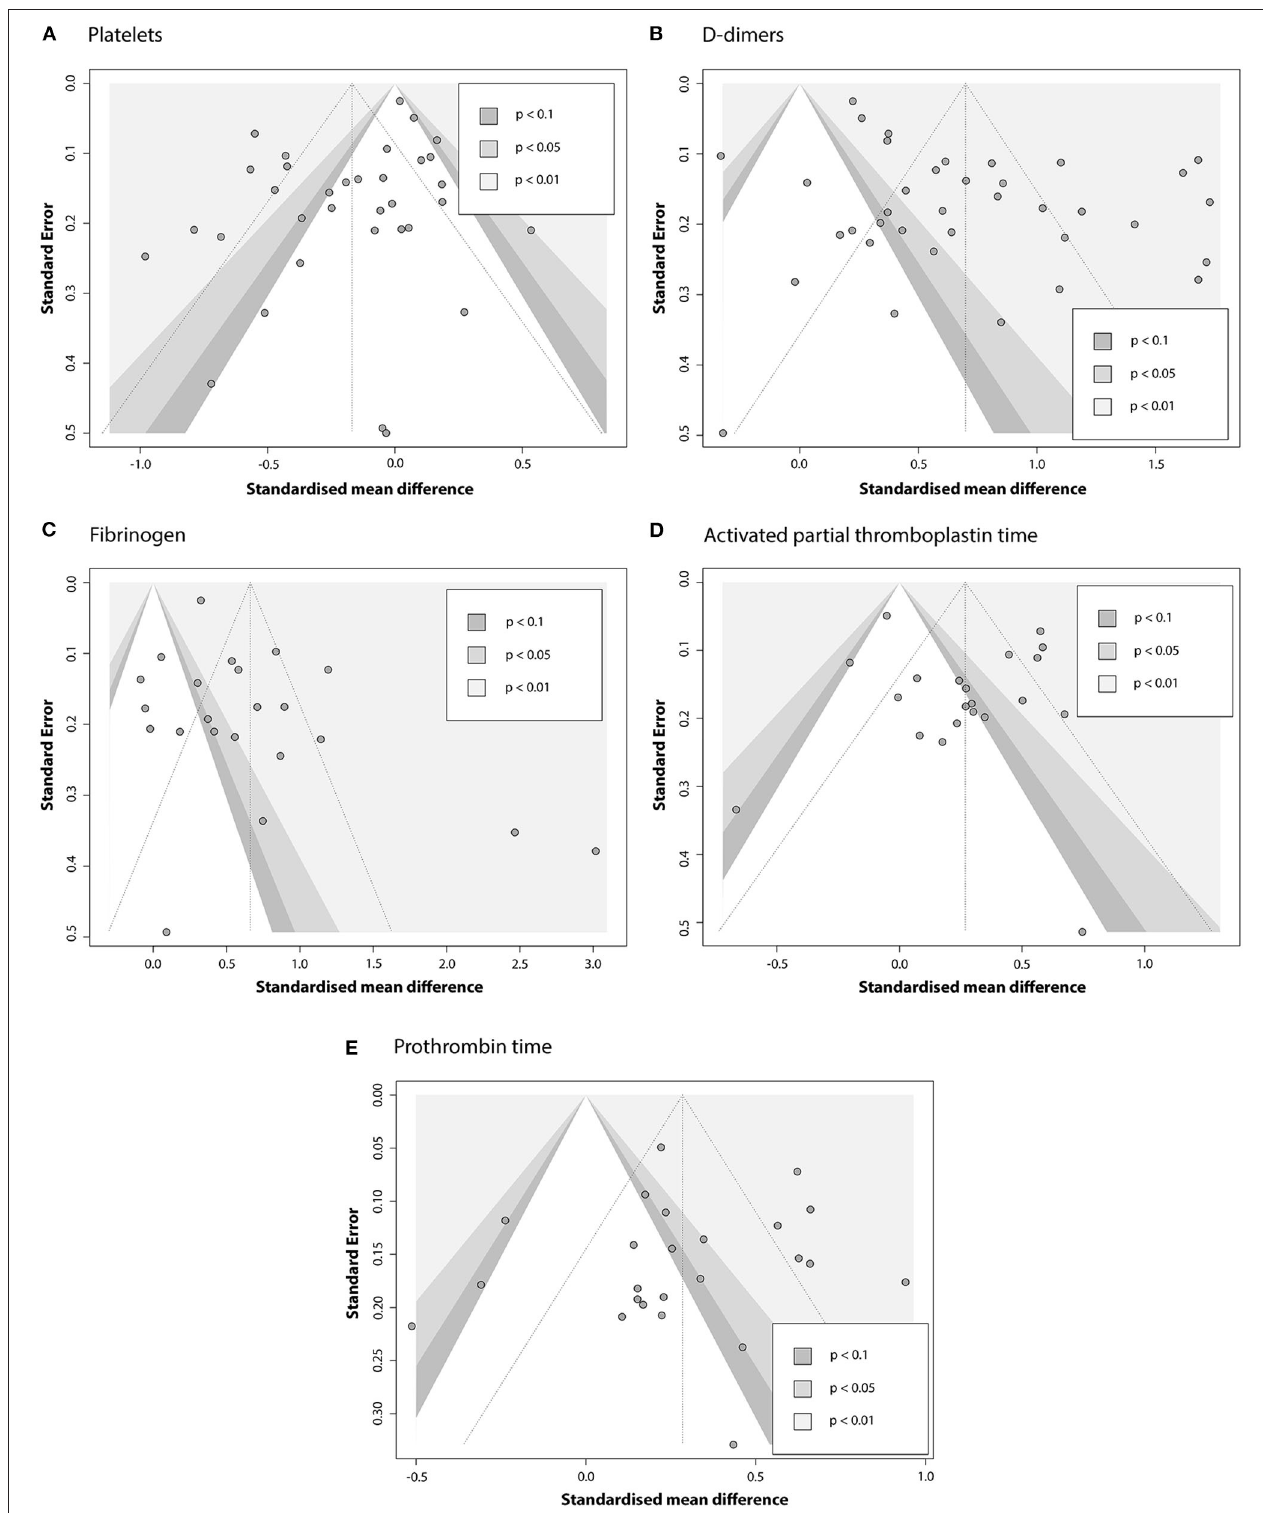
FIGURE 7 | Contour-enhanced funnel plots evaluating the presence of publication bias in the pool of articles that report association between COVID-19 severity and (A) PLT; (B) DD; (C) FIB; (D) APTT; (E) PT.